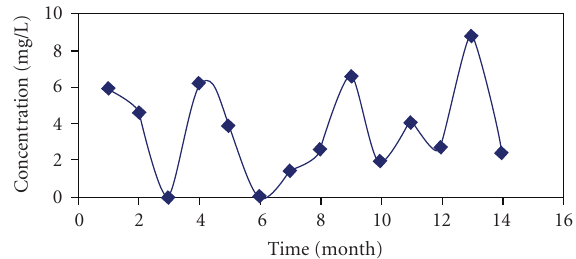
Figure 6: Total hardness concentration in the permeate.